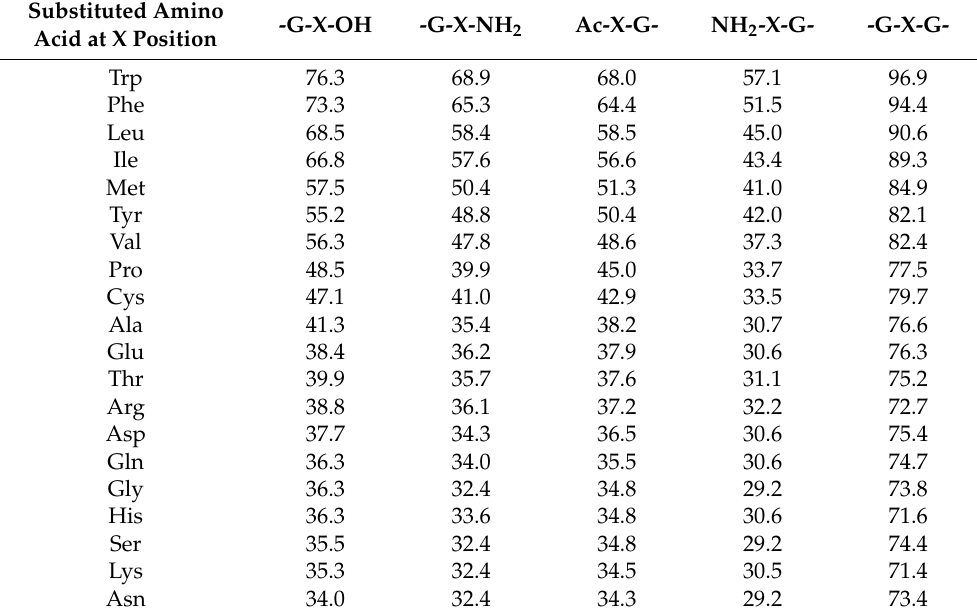
Table 13. Retention times of peptide models [31].